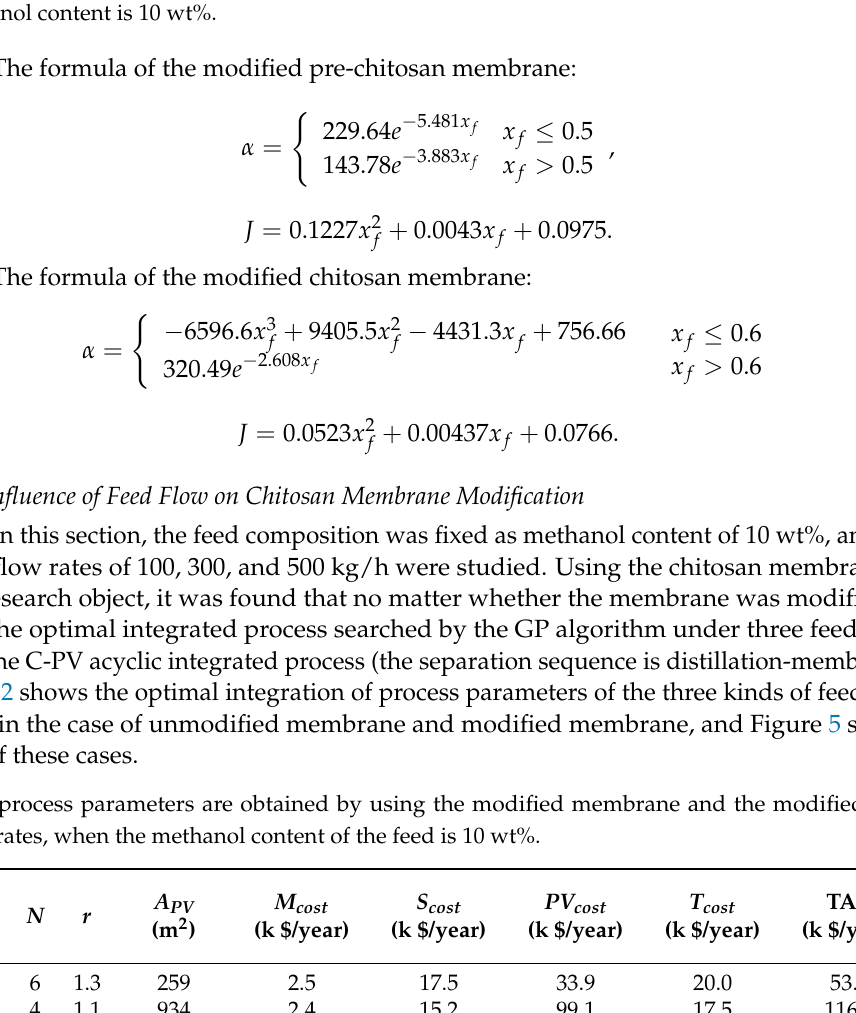
Figure 4. The optimal process and operation parameters when the feed flow rate is 100 kg/h and the methanol content is 10 wt%.